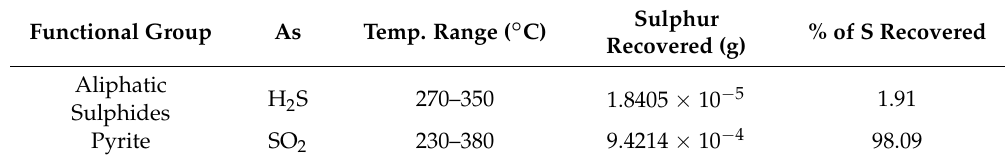
Figure 9. TPI of iron pyrite. Table 9. Results for the TPI of iron pyrite.